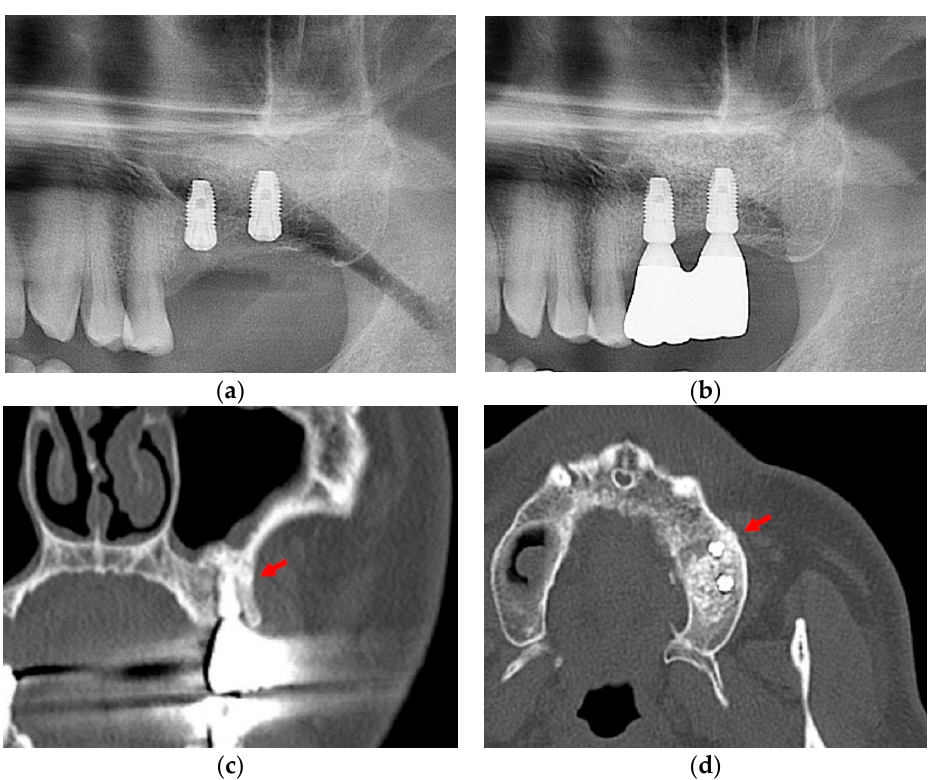
Figure 6. Maxillary sinus floor elevation through minimally invasive lateral approach (anorganic bovine bone graft without using barrier membrane): ( a ) panoramic radiograph immediately after maxillary sinus floor elevation; ( b ) after 6 months follow-up; ( c ) axial and ( d ) coronal view of computed tomography at 6 months after surgery. The osteotomy site was filled with graft material having an irregular surface (red arrows). Displacement of graft material was not observed.